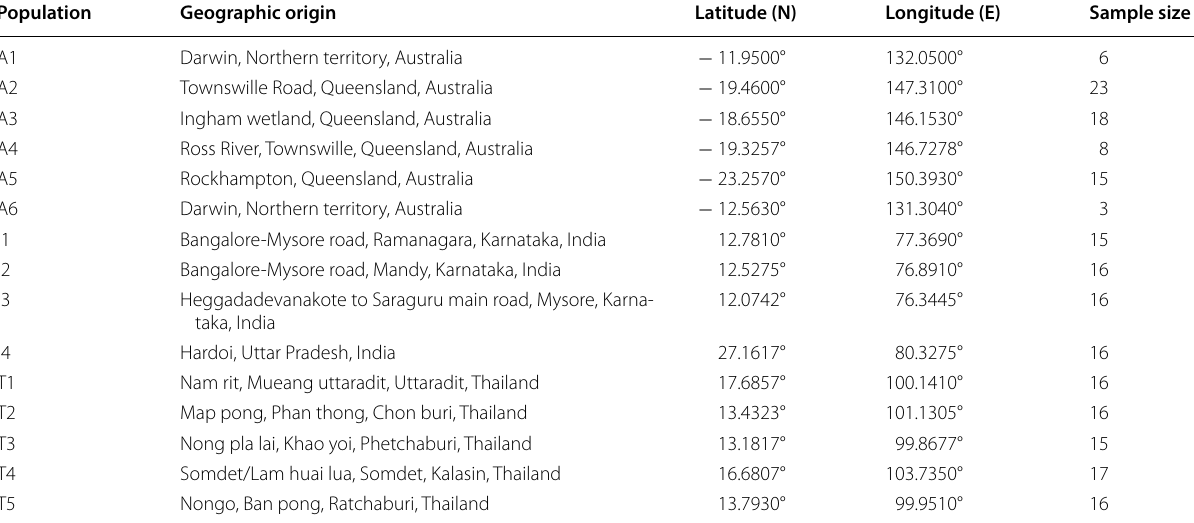
Table 1 Locations and sample size of N. nucifera populations investigated in the present study